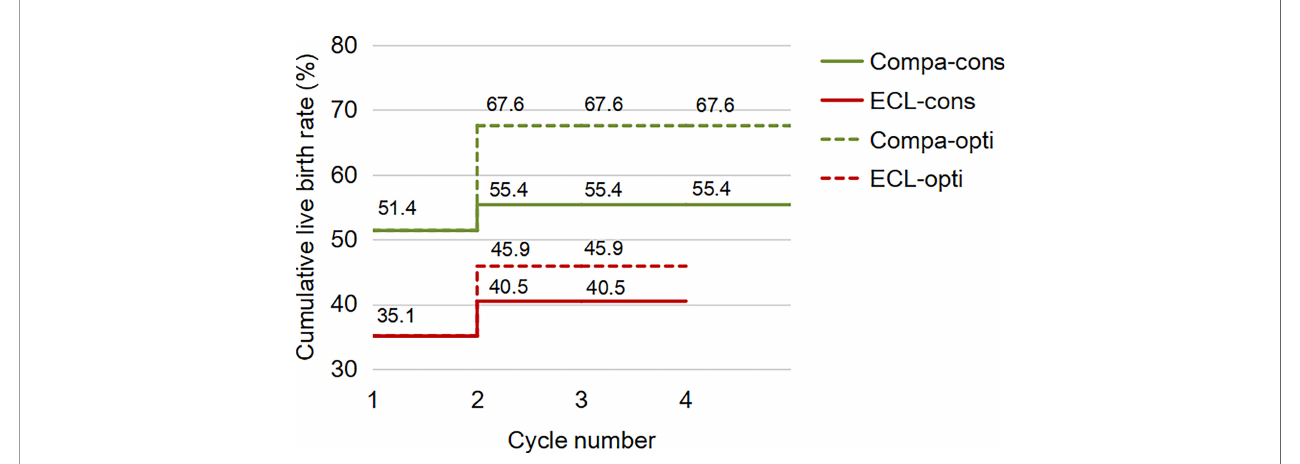
FIGURE 2 | The conservative and optimal CLBRs for up to four complete cycles in both groups. The CLBR was 35.1% for the fi rst complete cycle of the ECL group, rising to 40.5% (conservative) and 45.9% (optimal) for the second cycle. In the comparison group, the CLBR rose from 51.4% for the fi rst cycle to 55.4% (conservative) and 67.6% (optimal) for the second cycle. The difference of optimal CLBRs between the two groups was signi fi cant (P=0.033), although not signi fi cant for conservative CLBRs (P=0.139). CLBRs did not increase from the third cycle in either